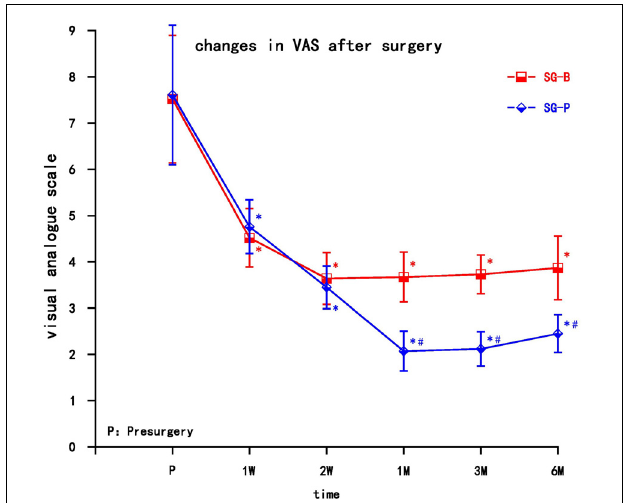
FIGURE 2 | Comparison of VAS pain scores pre-surgery and post-surgery in the two groups. At 1 and 2 weeks, VAS decreased in both groups ( P > 0.05); VAS decreased significantly in the SG-P group after 1 month ( P < 0.05). Results are presented as means ± SEMs. ∗ Compared to pre-surgery, P < 0.05; # Compared with SG-B group, P < 0.05.